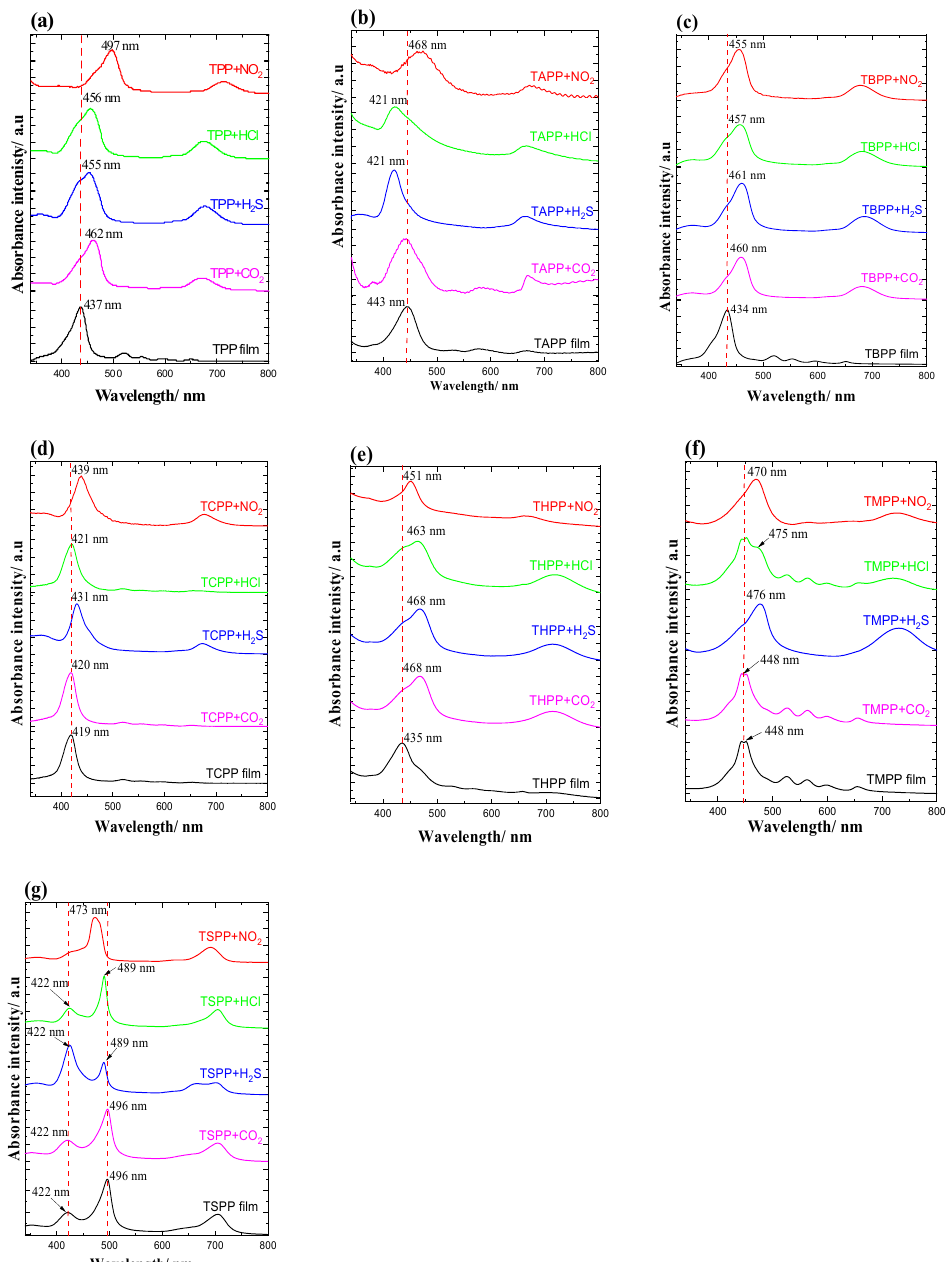
Figure 6. UV-Vis spectrometric response of porphyrin films exposing to analyte gases (100 ppm) ( a ) TPP, ( b ) TAPP, ( c ) TBPP, ( d ) TCPP, ( e ) THPP, ( f ) TMPP, ( g ) TSPP.